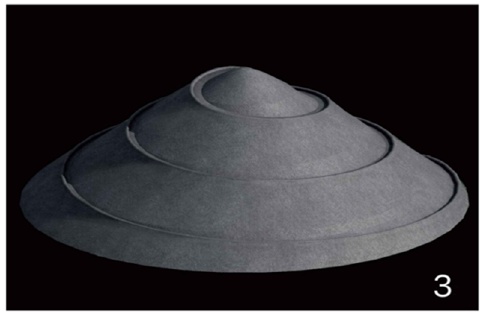
Figure 3. Final scheme indication of interception system (gutter mode).